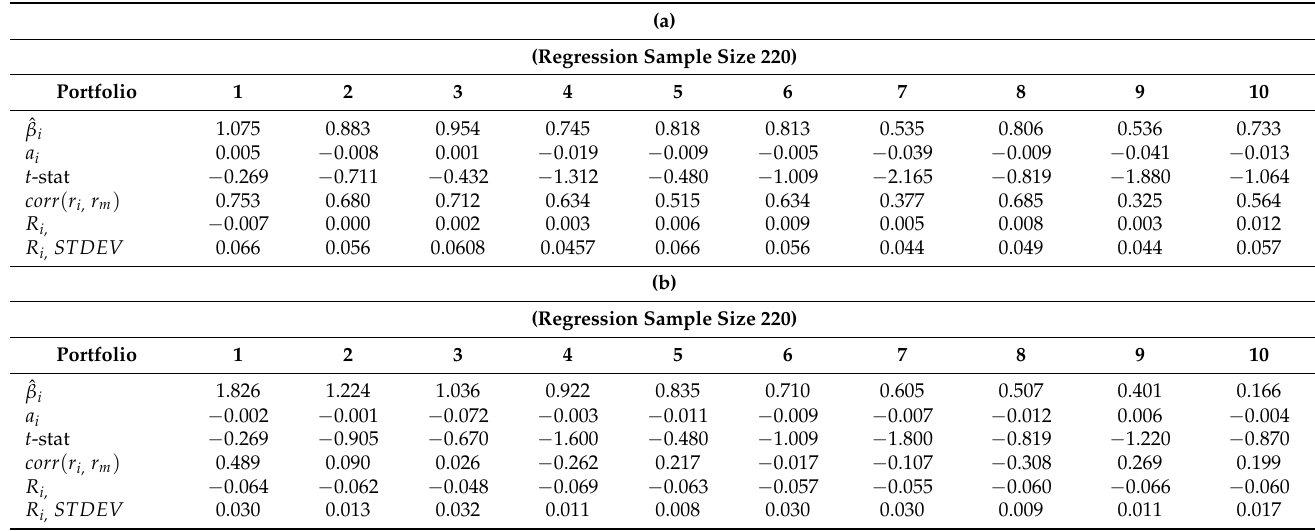
Table 3. ( a ) Results for time-series first-pass regression (weighted portfolios) (May 2016 to June 2021); ( b ) results for time-series first-pass regression (beta-sorted portfolios) (May 2016 to June 2021).